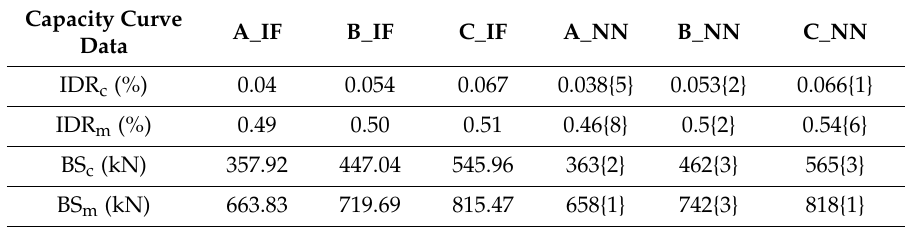
Figure 6. Capacity curves of RC infilled frames A ( a ), B ( b ) and C ( c ) with and without masonry infill in comparison with NN results. Table 8. Evaluation of compatibility of neural networks processing for infilled frames A, B and C.